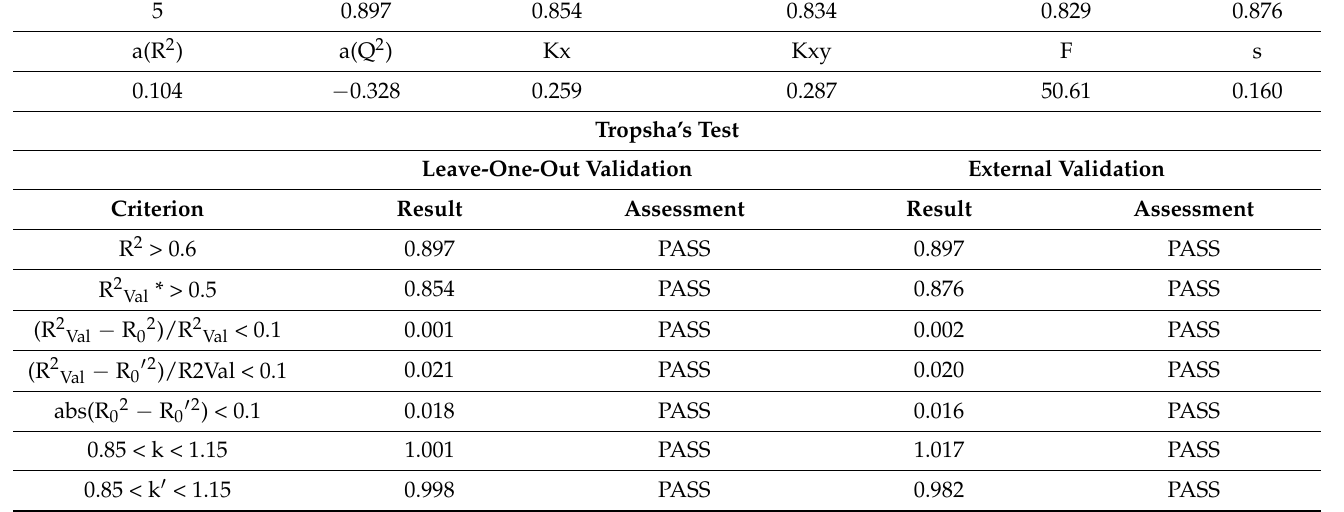
Table 1. Statistical parameters for model M13 obtained by the 2D-3D modeling and Tropsha’s test results. N ◦ of